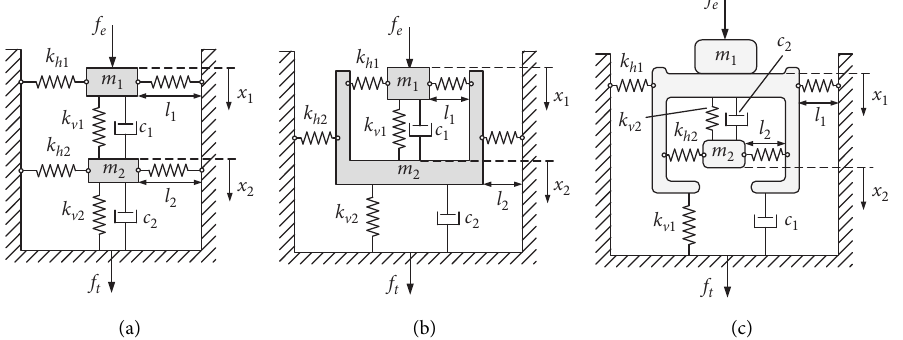
Figure 1: Schematic diagrams of three types of nonlinear two-stage isolators. The payload is set on the upper stage in each type: (a) type I isolator of which two stages are both connected to the foundation [3]; (b) type II isolator of which upper stage has no direct connection with the foundation [4]; (c) type III isolator of which lower stage only connects with the upper